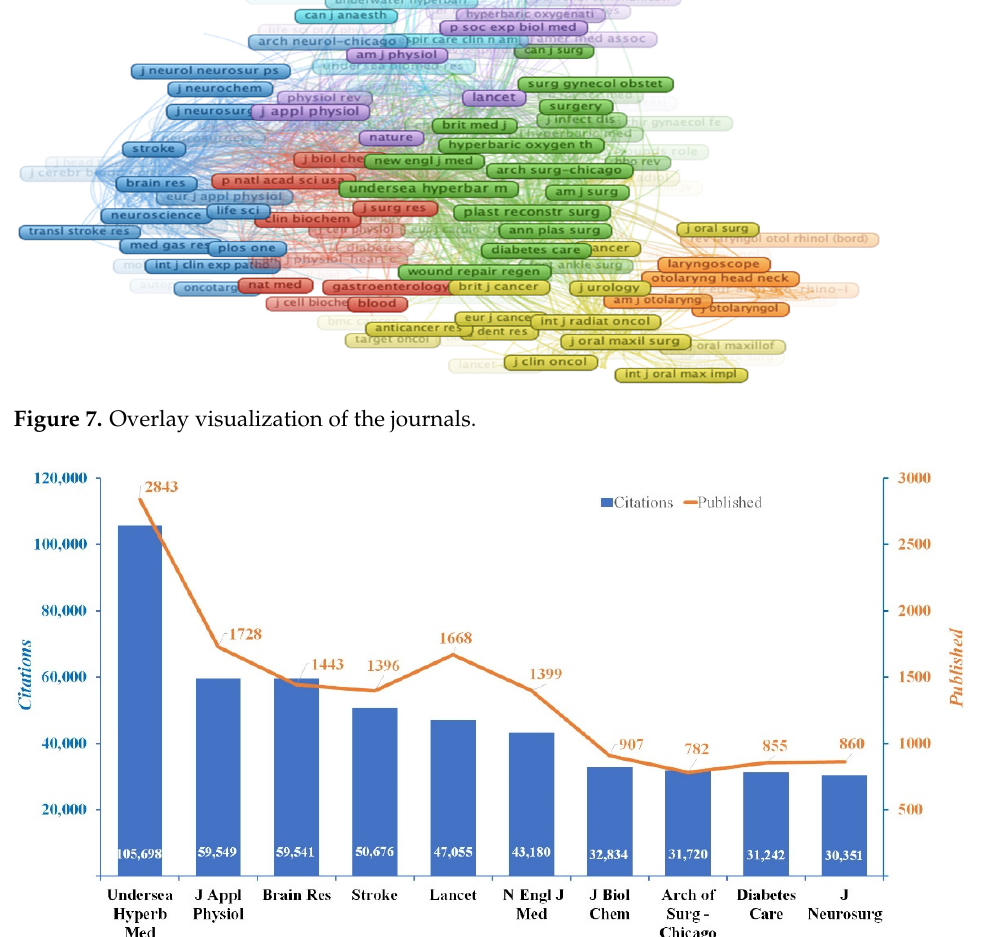
Figure 8. Distribution of journals publishing studies related to HBOT research.